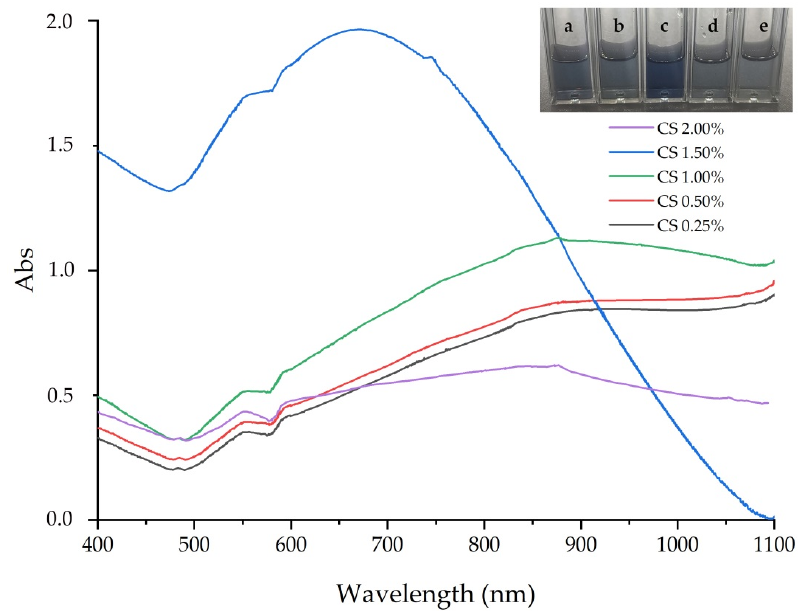
Figure 1. Absorption spectra of GNS prepared in various mass concentrations of CS: ( a ) 0.25%, ( b ) 0.50%, ( c ) 1.0%, ( d ) 1.5% and ( e ) 2.0%. Table 1. The influence of mass concentration of chitosan to surface plasmon resonance and inten- sity absorbance.